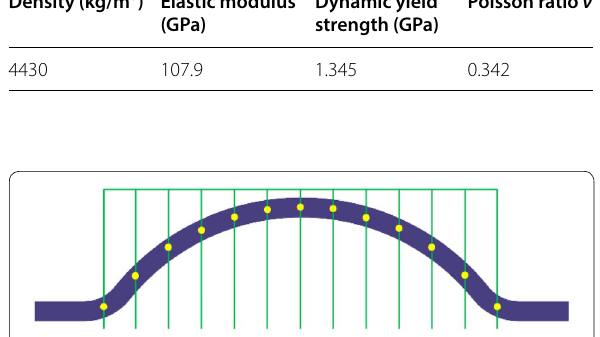
Figure 6 Arrangement of measuring points for measuring thickness distribution of bulging parts